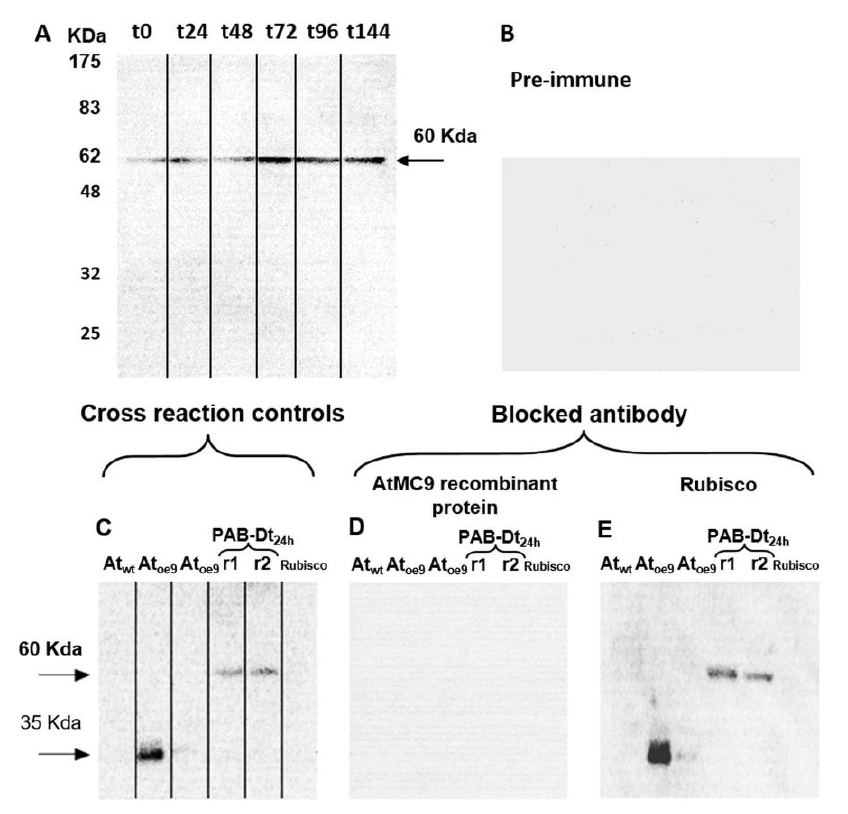
FIGURE 2. MCs immunodetection